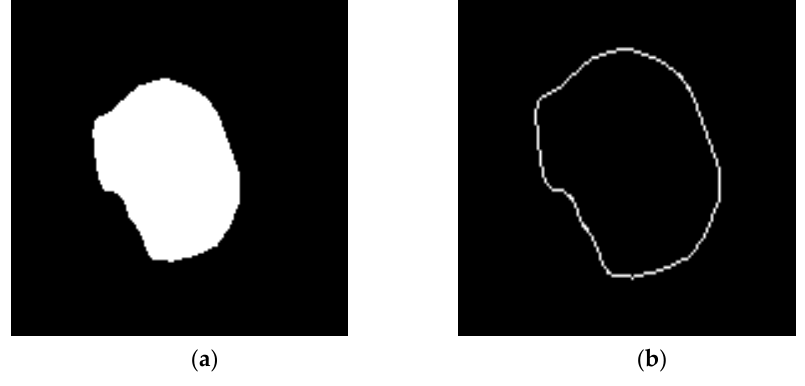
Figure 4. ( a ) Binary image, ( b ) border extraction.